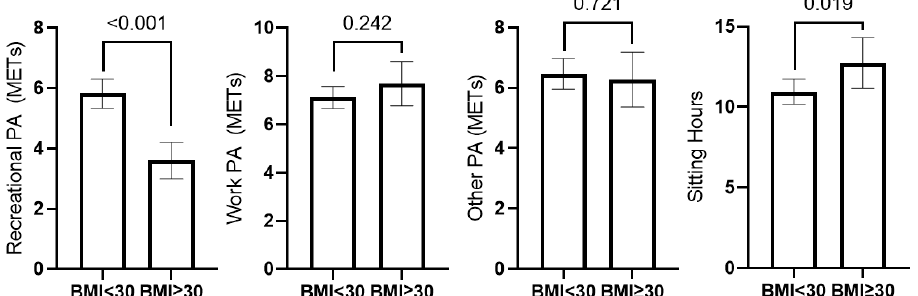
Figure 3. Physical Activity (PA) types in daily Metabolic Equivalents (METs) and daily sitting time in hours by obesity status.